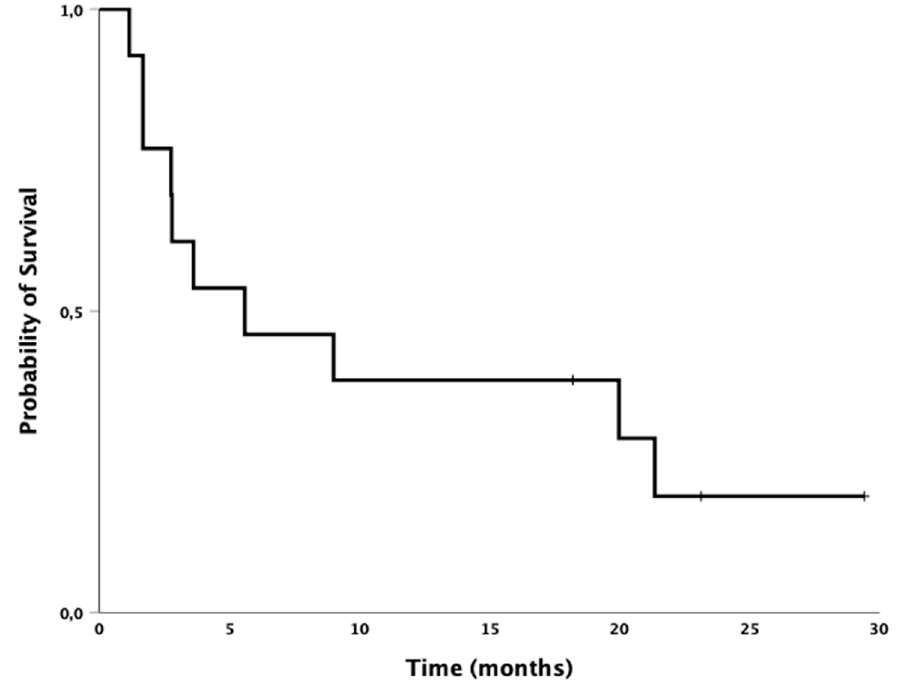
Figure 2. Kaplan–Meier survival analysis. Median overall survival for all patients ( n = 13) was 5.6